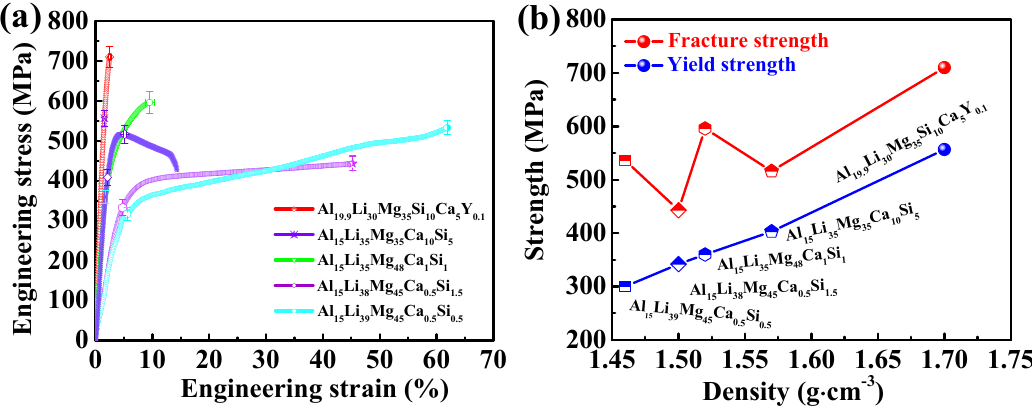
Figure 3. Mechanical properties of five ULW-CCAs. ( a ) Engineering stress–strain curves. ( b ) Relationships between yield strength, fracture strength, and density. The BSE image of the Al 19.9 Li 30 Mg 35 Ca 10 Si 5 Y 0.1 ULW-CCA is shown in Figure 4a, indicating that